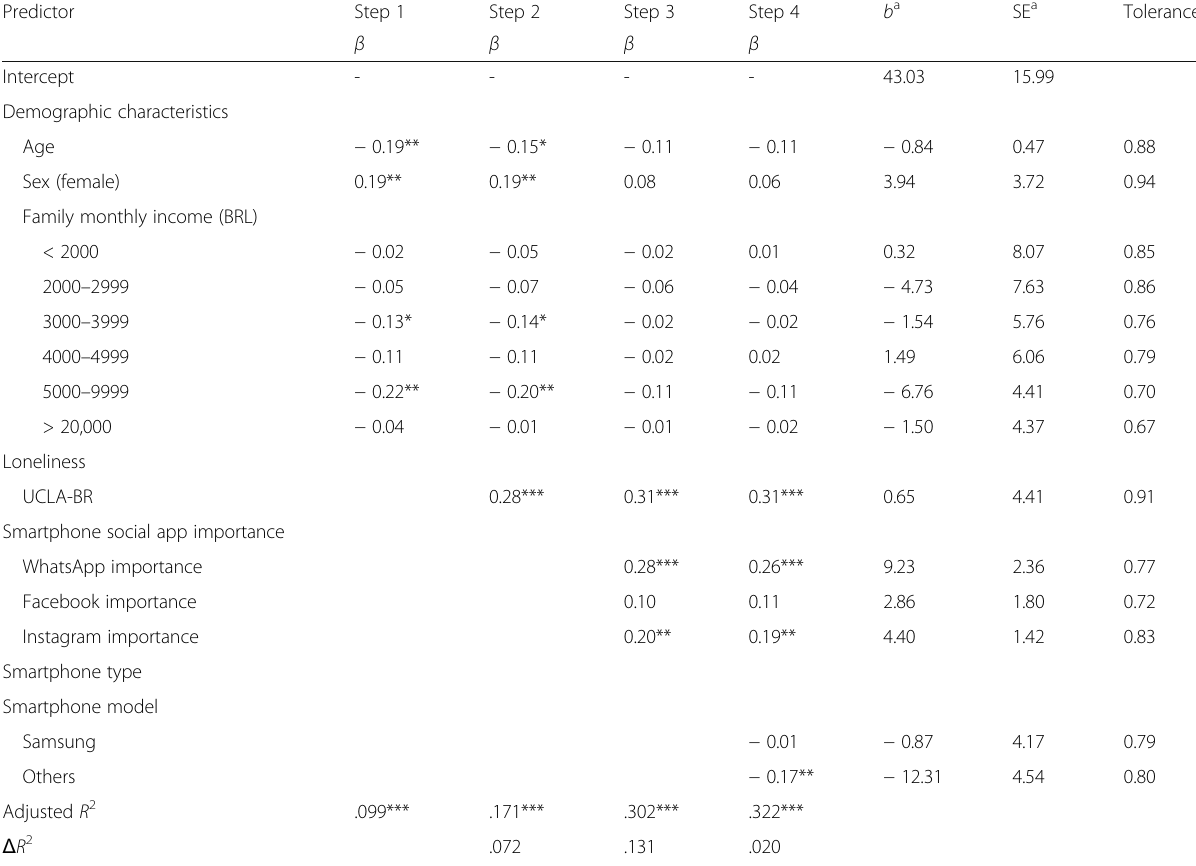
Table 3 Hierarchical regression analysis predicting problematic smartphone use, their standardized and unstandardized coefficients, the standard error (SE), and tolerance